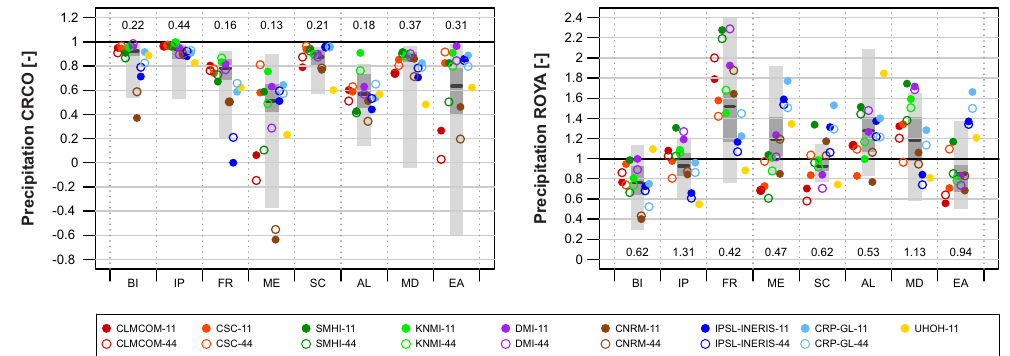
Figure 14. As Fig. 13 but for the mean annual cycle of precipitation. The numbers along the x axes indicate the standard deviation of the mean annual cycle (left panel) and the maximum difference between the climatological monthly means (right panel), both normalized by the annual mean monthly precipitation and based on average precipitation sums over the respective subdomain in the E-OBS